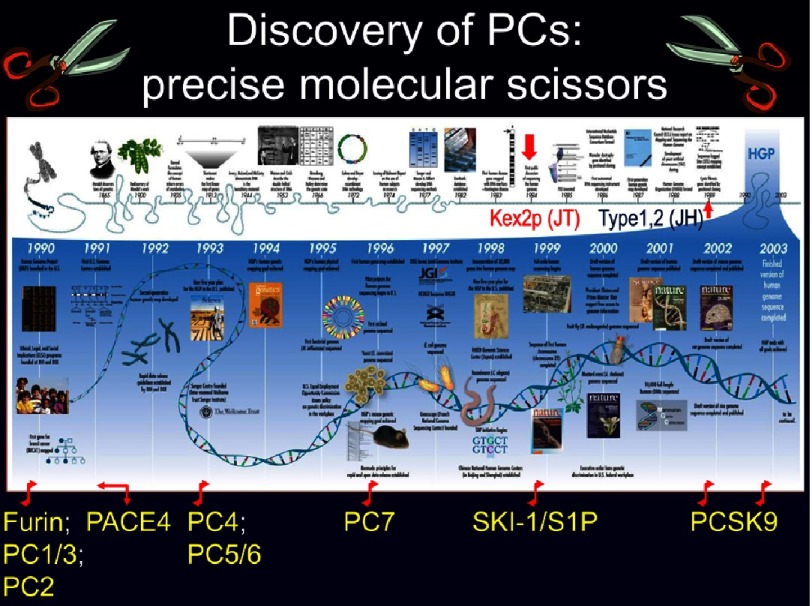
History of the discovery of the proprotein convertases.The first discovery of Kexin in 1984, led the way to the identification of its 9 mammalian homologues from 1990–2003.